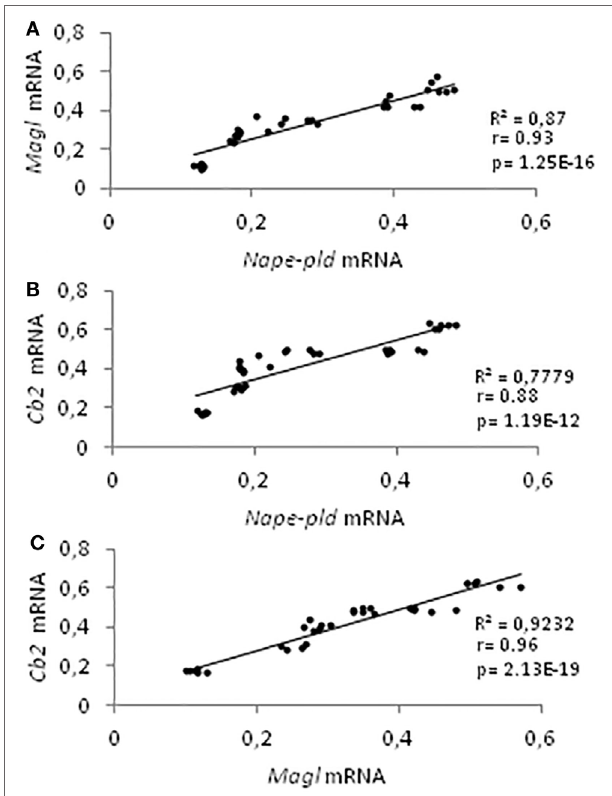
FigUre 4 | Correlation analyses among endocannabinoid system components. Correlation analyses between Nape-pld and Magl (a) , Nape-pld and Cb2 (B) , Magl and Cb2 (c) mRNA expression, from 21 to 60 days post partum